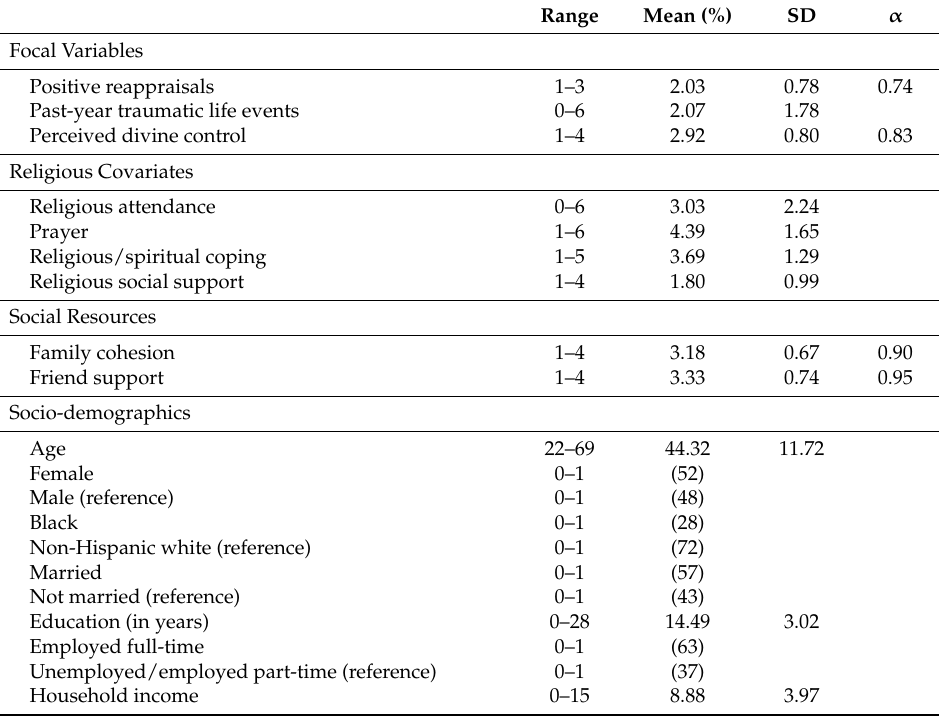
Table 1. Weighted descriptive statistics (NSAHS,